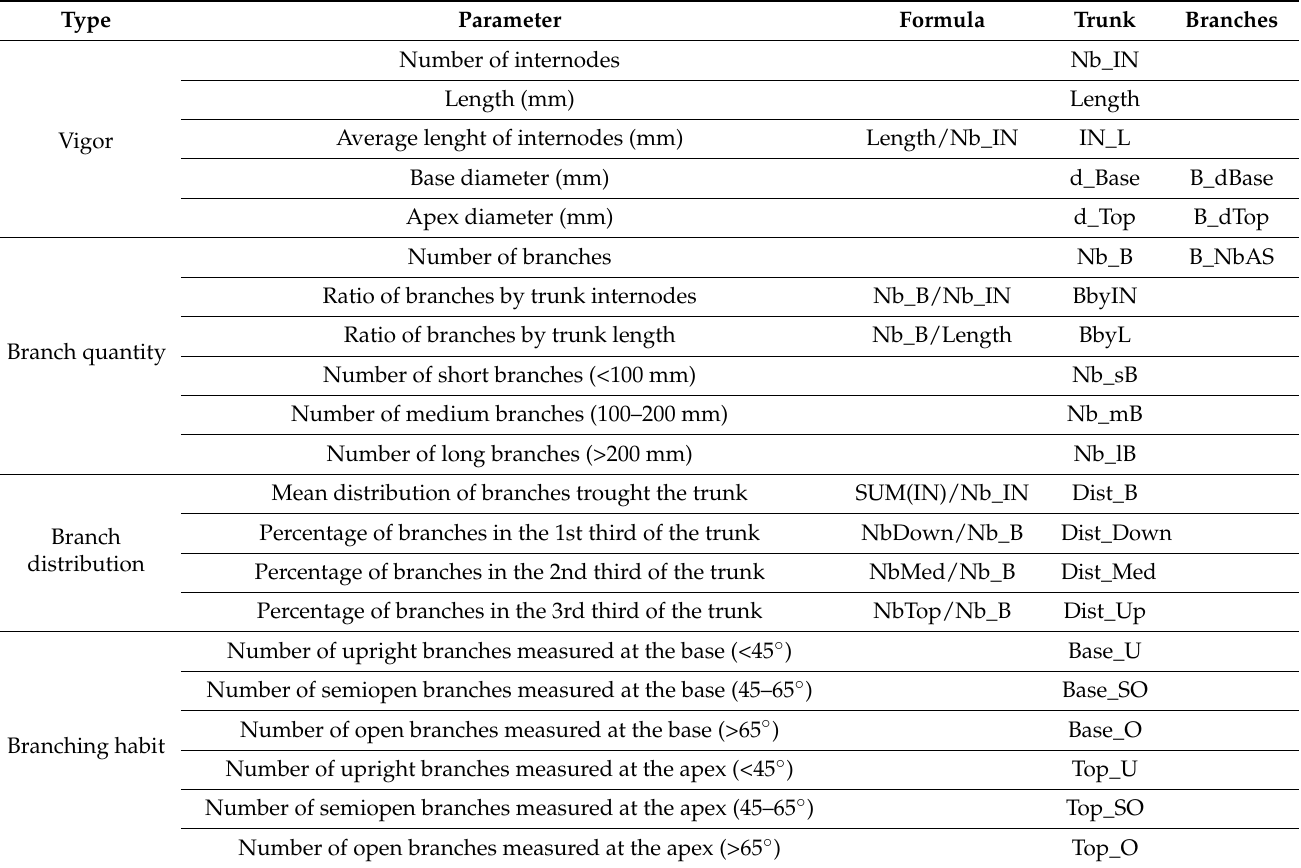
Table 1. Parameters used to quantify aspects of almond tree architecture and the corresponding formula if parameters were calculated from other traits. Data were measured on the primary